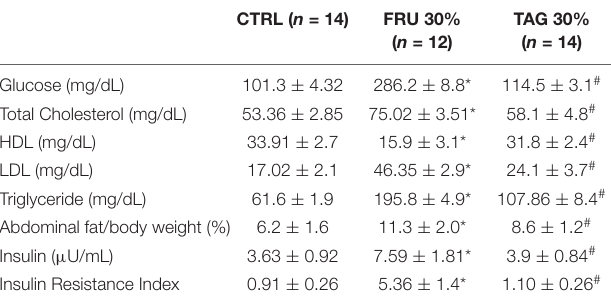
TABLE 1 | Effects of fructose (FRU 30%) and tagatose (TAG 30%) enriched diets in comparison to a standard diet (CTRL) on glucose and lipid metabolism. CTRL ( n = 14) FRU 30% TAG 30% ( n = 12) ( n =